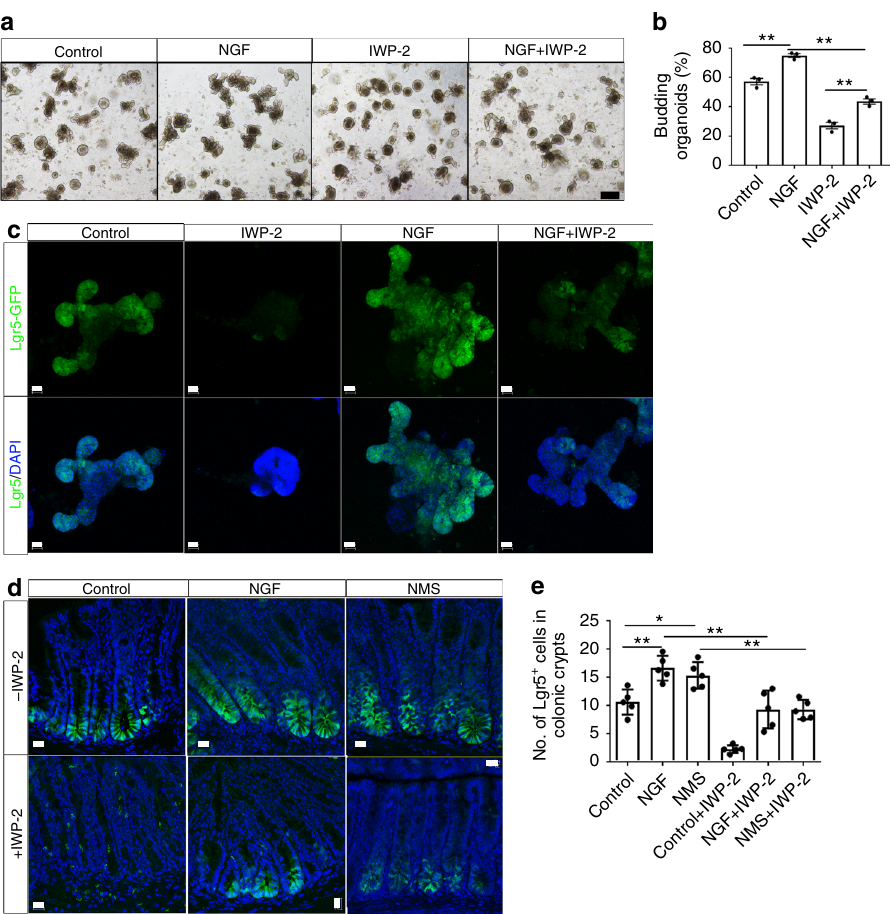
Fig. 6 NGF promotes the expansion in intestinal stem cells through Wnt signaling. a Representative images of intestinal organoids cultured with a combination of NGF and IWP-2 (scale bars: 100 μ m). The ef fi ciency for organoid formation was shown in b (** p < 0.01, n = 3 per group; ANOVA). c The expression of Lgr5 (green) in Lgr5-EGFP + organoids cultured in a combination of NGF and IWP-2 was visualized by confocal imaging (scale bars: 20 μ m). d Confocal imaging shows the distribution of Lgr5 + CSCs (green) in the sections of proximal colon from both control and NMS Lgr5-EGFP + mice intraperitoneally injected with a combination of NGF and K252a (left panel). The quanti fi cation for the average number of Lgr5 + CSCs per colonic crypt was shown in e (* p < 0.05, ** p < 0.01, n = 5/group; ANOVA) (scale bars: 20 μ m). All data represent the mean ± SEM